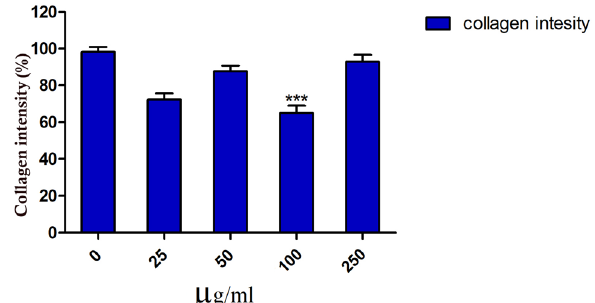
Figure 4. Morphometric analysis of the collagen intensity in Tilapia fish skin under different concentrations of Ag NPs. The collagen intensity was measured using ImageJ software (version 1.48v). The results are expressed as a percentage from the total number of pixels and are normalized to control-treated group. Differences were evaluated using one-way ANOVA. *** p < 0.0001